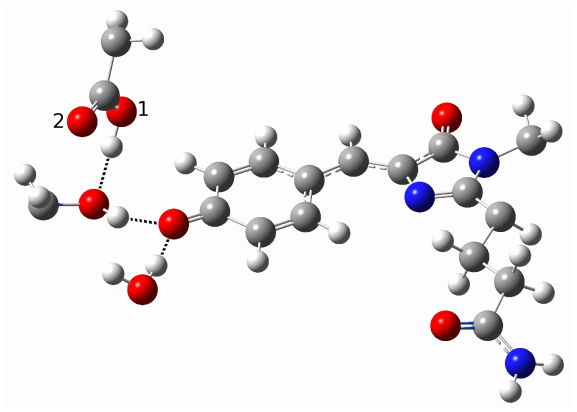
Figure 14. psamFP488 in anionic form optimized in the ground